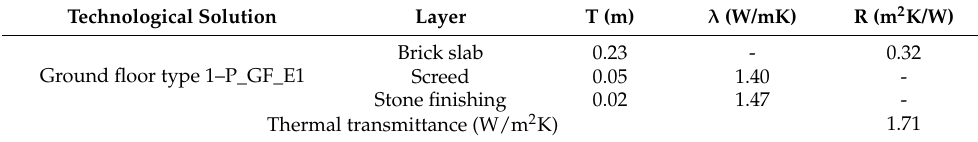
Table A1. Existing ground floor stratigraphy (P_GF_E1).